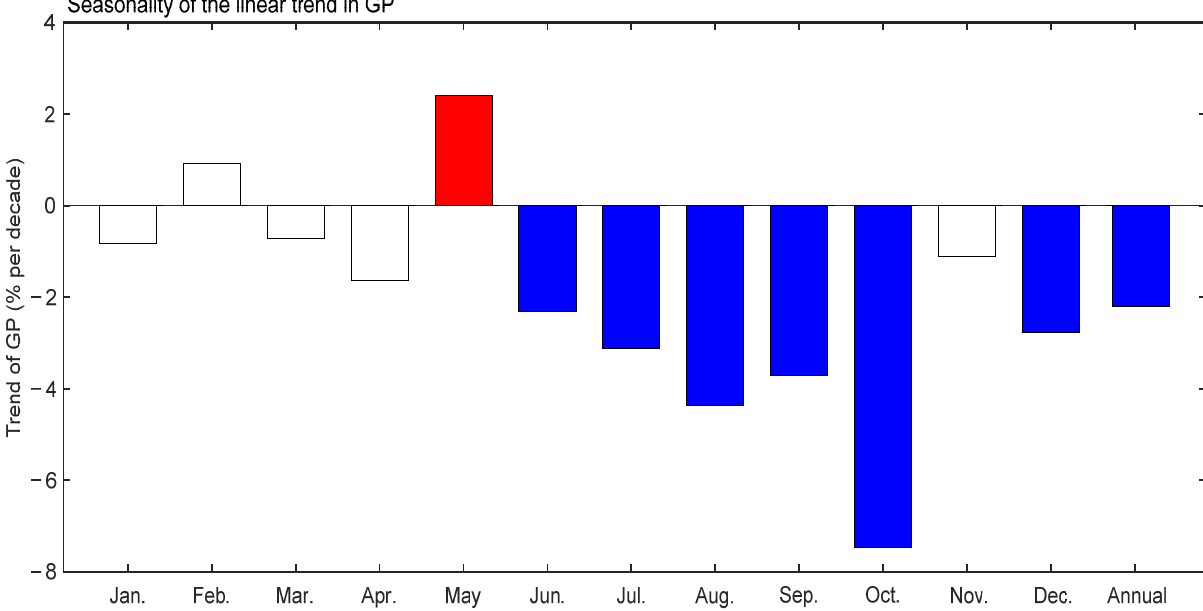
Figure 2. The seasonality of the linear trend in GP of WNP TCCs during 1982–2009. The red (blue) bar indicates that the increasing (decreasing) trend exceeds the 95% confidence level. The white bar indicates that the trend is not significant at the 95% confidence level.